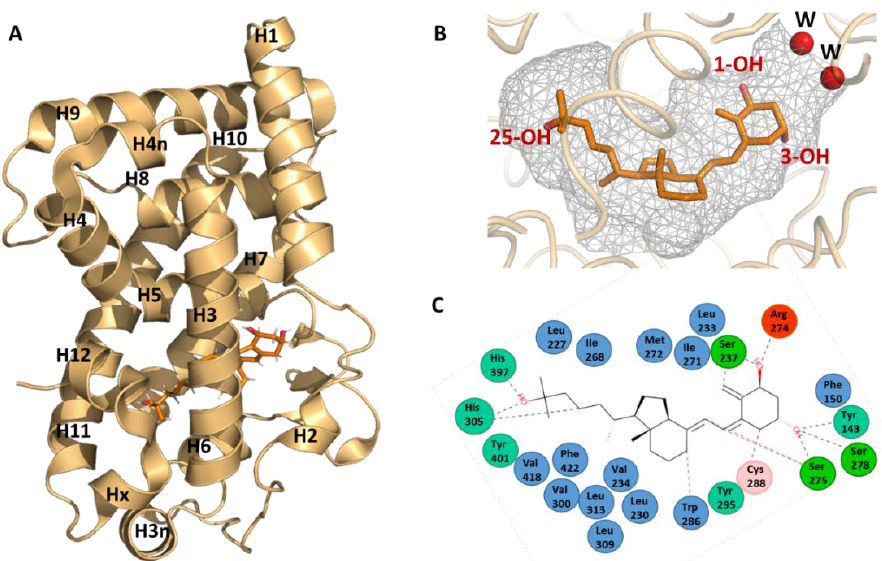
Figure 3. 1,25D 3 recognition by VDR. ( A ) Overall structure of the hVDR LBD. The hVDR LBD bound to 1,25D 3 is composed of 15 helices and 1 β -sheet (PDB ID: 1DB1 and 7QPP) [20,39]. ( B ) Conformation of 1,25D 3 in the VDR LBP shown as a grey surface. ( C ) Interaction map of 1,25D 3 in the LBP of hVDR.